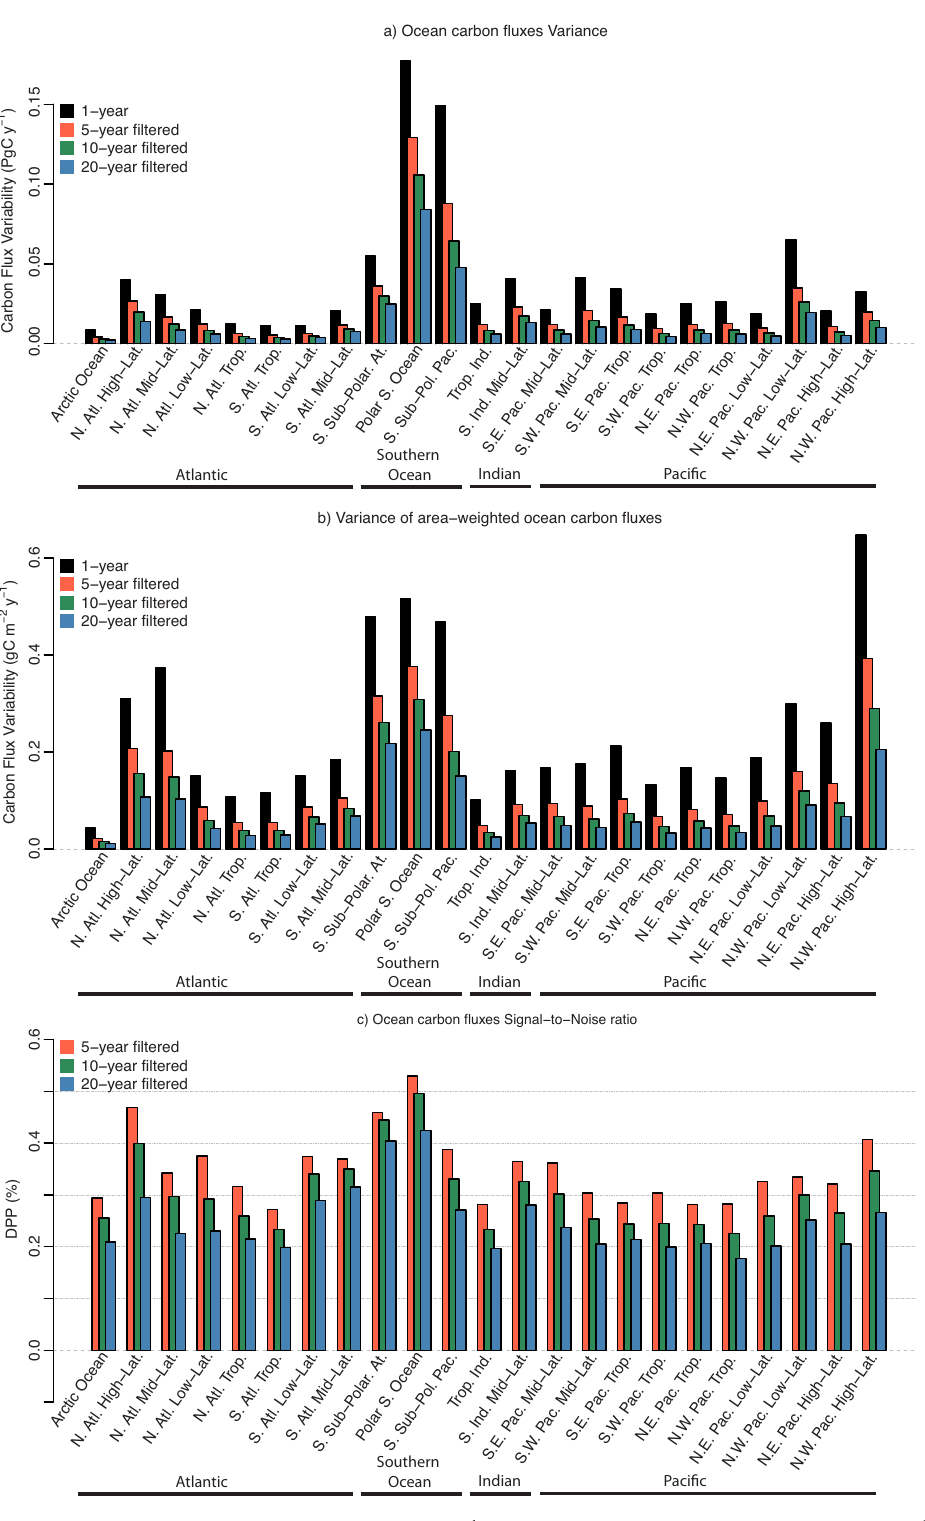
Fig. 3. Regional variability of (a) the ocean carbon uptake (in PgCyr − 1 ) and the area-weighted carbon fluxes (in gCm − 2 yr − 1 ) at (b) 1yr (interannual), 5-, 10- and 20yr time-scales. The signal-to-noise ratio (c) of these different variances is estimated by DPP metric (Eq. 2) for the various oceanic